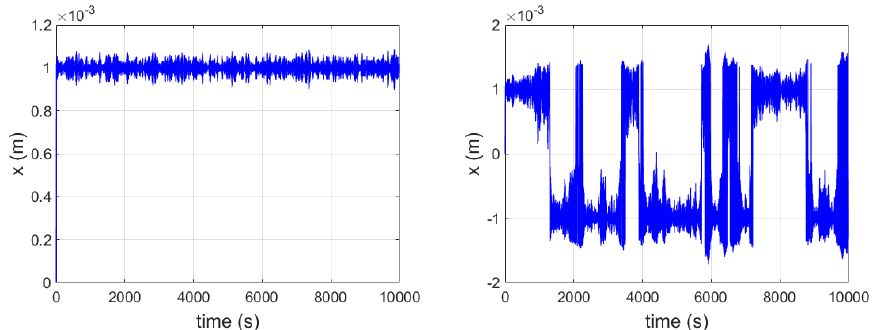
Figure 6. Position versus time for the energy harvester with matched load. On the left: Noise intensity ε = 10 − 3 . On the right: noise intensity ε = 5 · 10 − 3